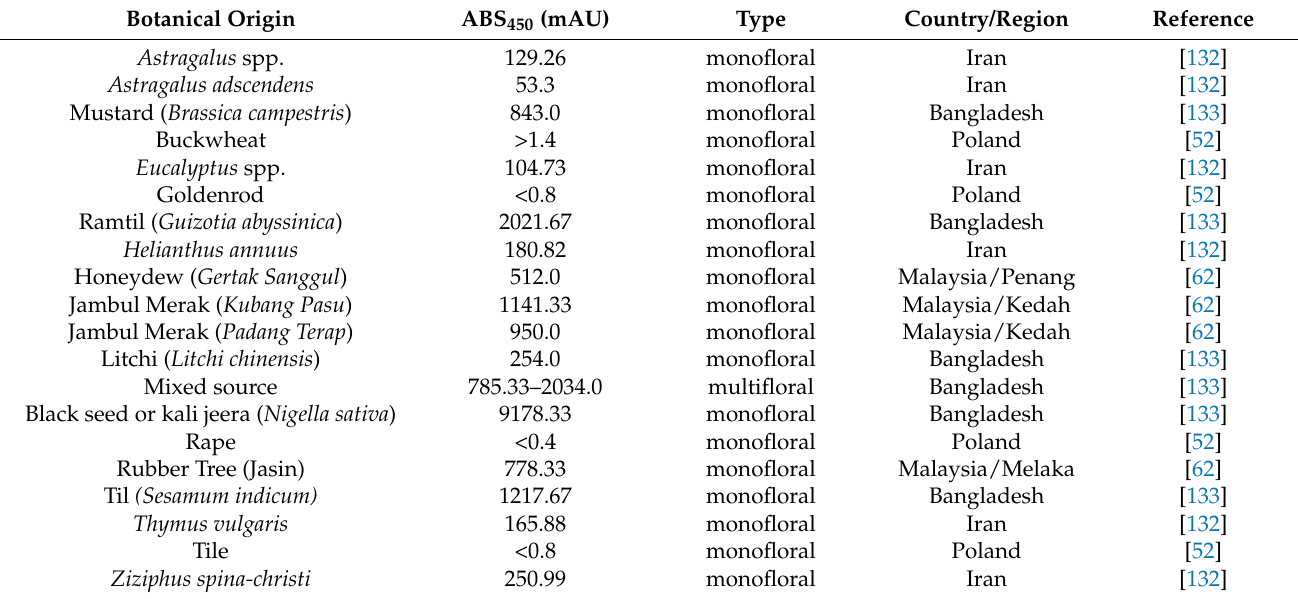
Table 4. ABS 450 values for honeys of different floral